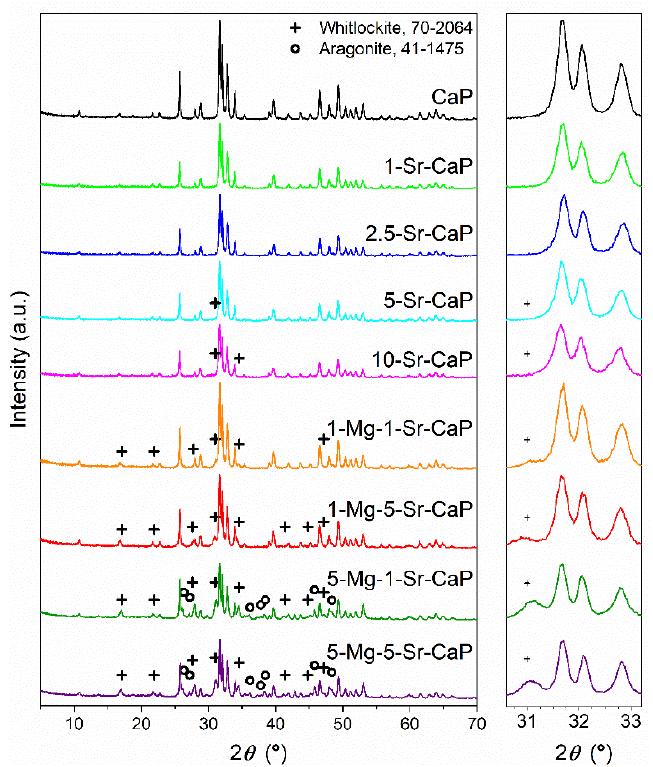
Figure 1. XRD patterns of prepared scaffolds. The 2 θ positions of whitlockite and aragonite are marked with + and ○ , respectively. The HAp (09-432) positions were not marked for clarity. Table 2. Results of quantitative analysis of samples obtained through whole powder pattern de- composition of XRD data. Resultant weighted factor, R wp , which indicates agreement between the calculated and the experimental data, of each refinement is shown in the last column.